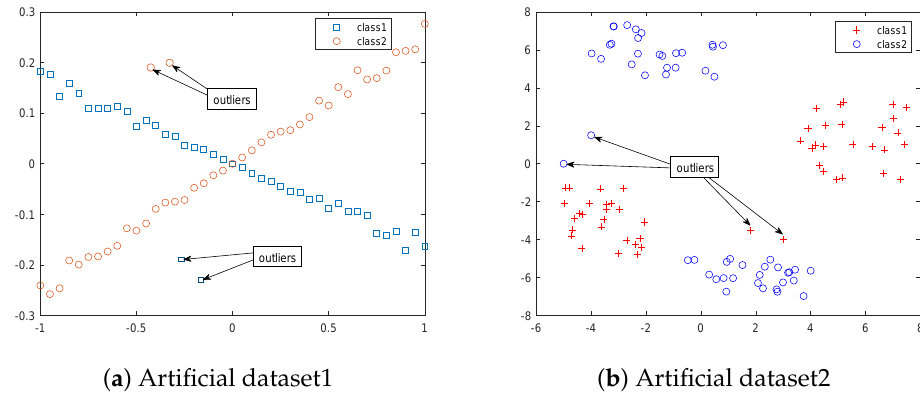
Figure 2. Distribution of artificial datasets with